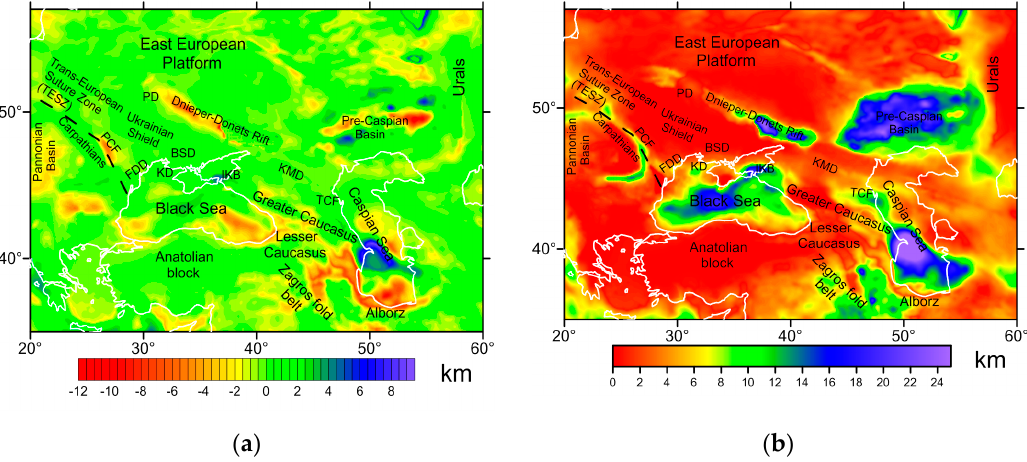
Figure 7. ( a ) Correction for the initial model of the sedimentary thickness (Figure 3a) obtained in the inversion of the decompensative gravity anomalies (Figure 6b); ( b ) final map of the sedimentary thickness. See text for detailed explanations.